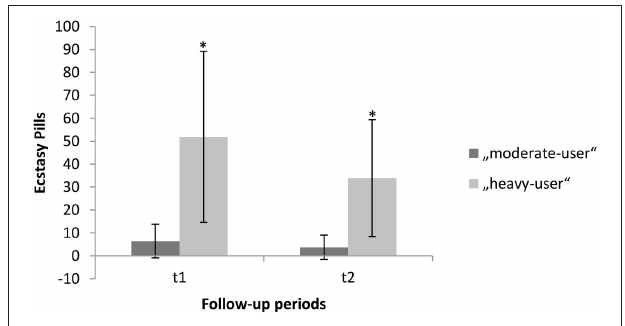
mean. * Significant difference between time-point 2 (t1) and time-point 3